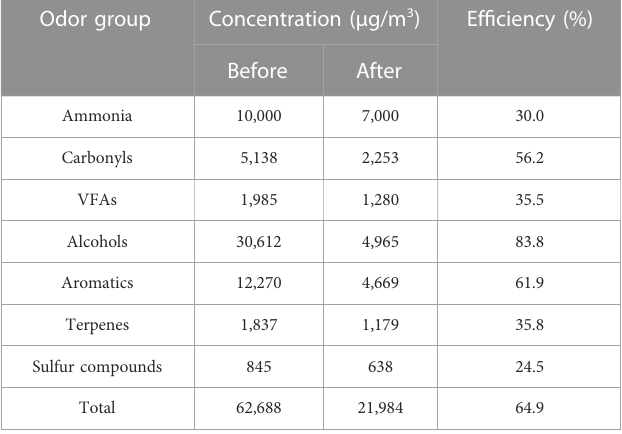
TABLE 1 Puri fi cation ef fi ciency of seven groups of